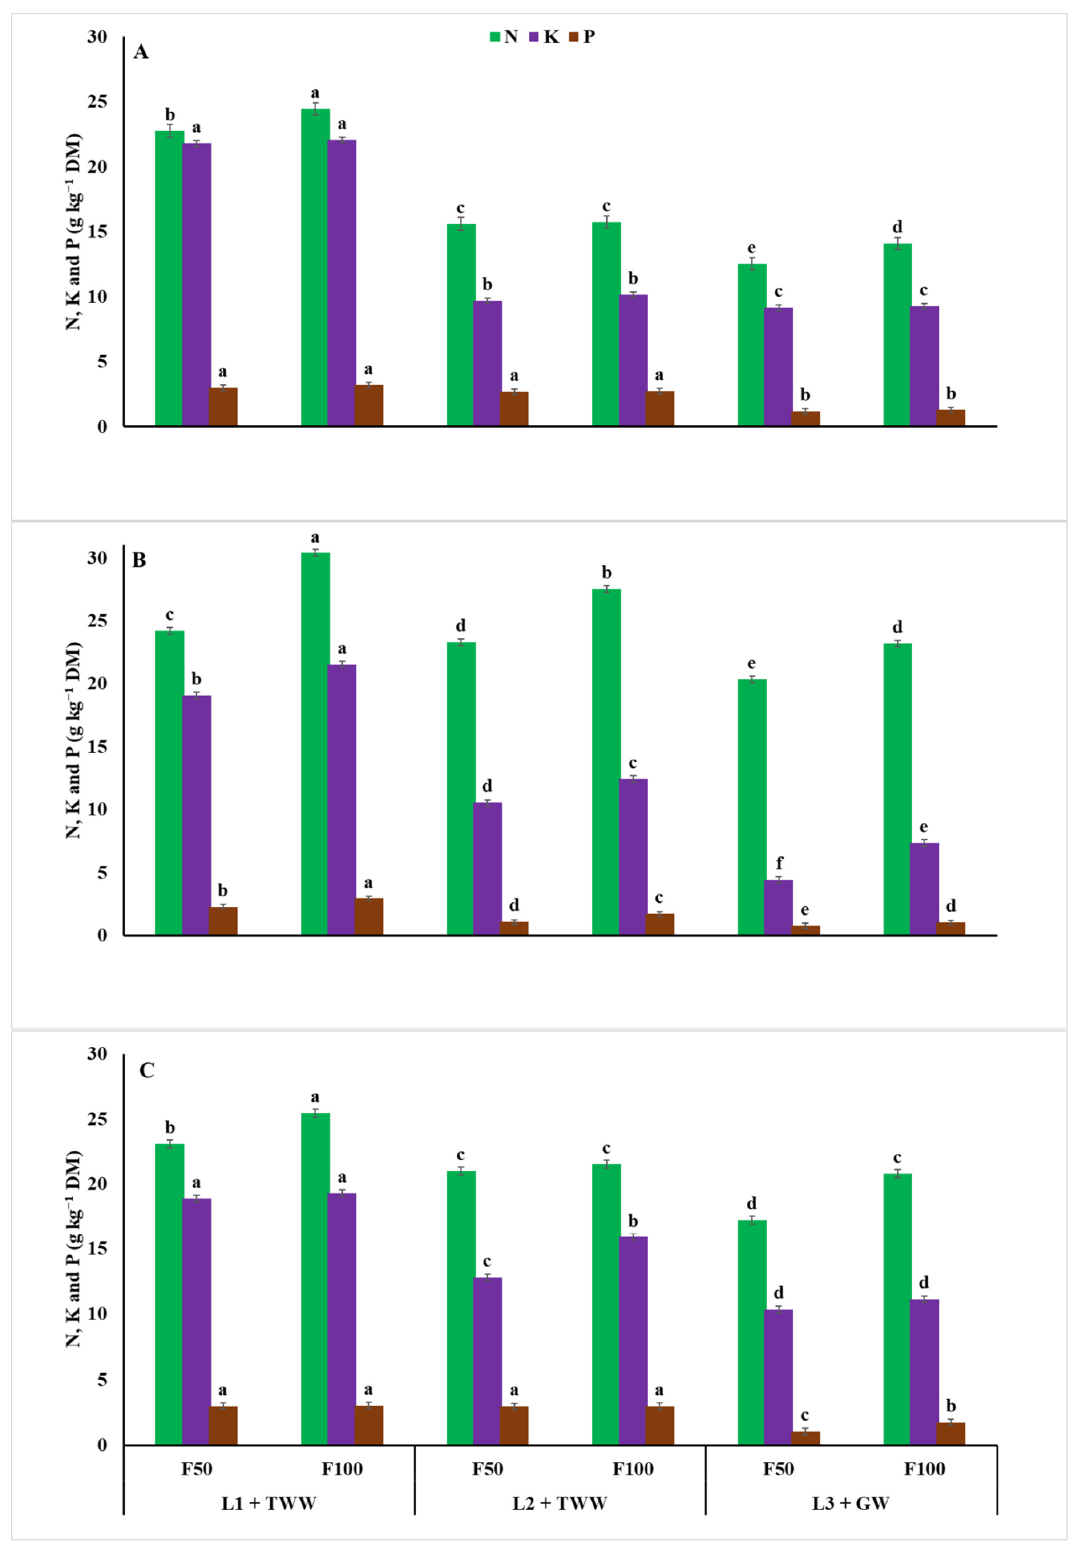
Figure 4. Interaction effects of water resources and fertilization treatments on nitrogen (N), potassium (K) and phosphorus (P) contents in biomass of safflower ( A ), canola ( B ), and triticale ( C ). Old soil with treated wastewater (L1 + TWW), virgin soil with treated wastewater (L2 + TWW), virgin soil with groundwater (L3 + GW), half-dose NPK (F50), full-dose NPK (F100). Values followed by the same letter were not significantly differed for each trait.